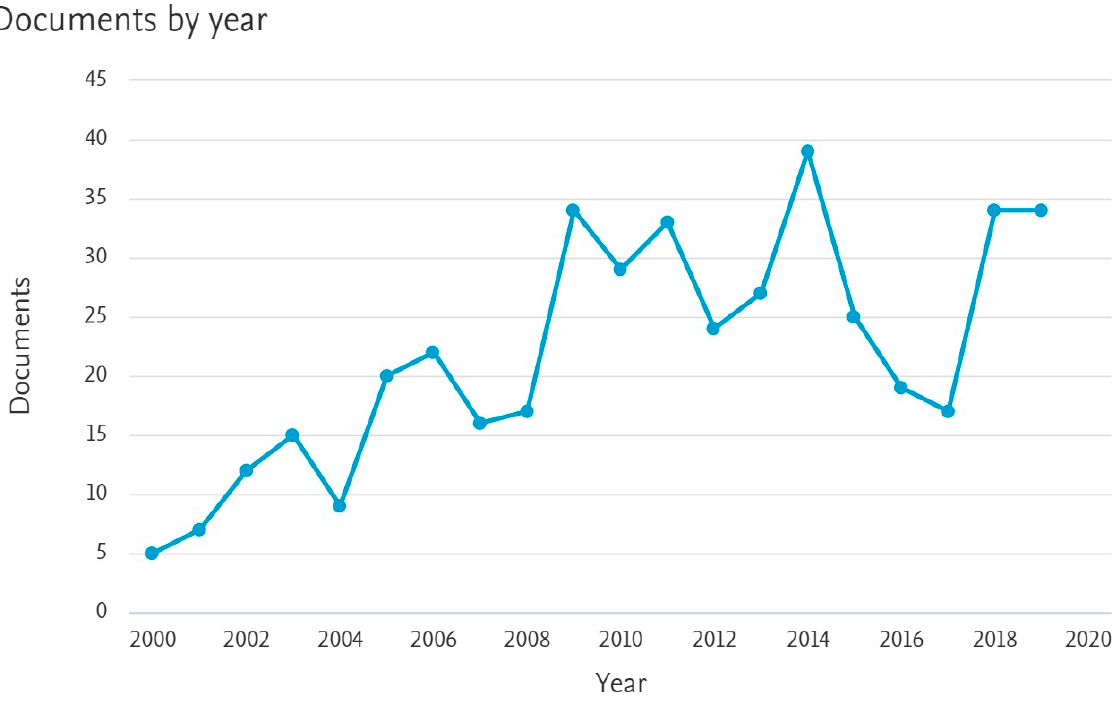
Figure 1. Trends of publications.